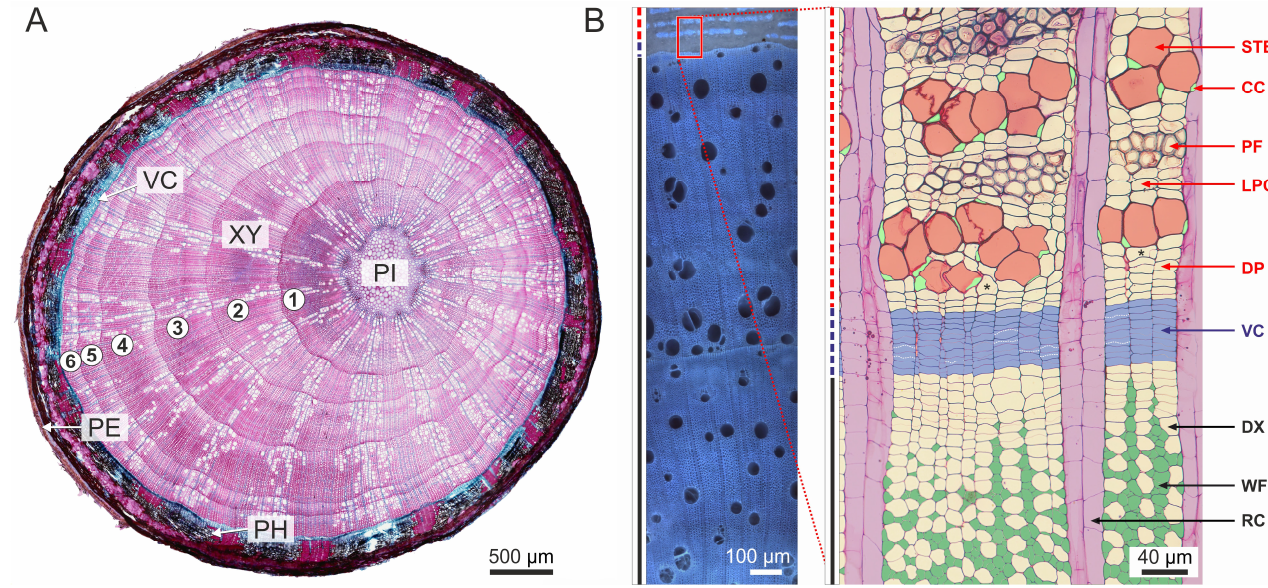
Figure 1. Transverse sections of stems of broadleaved tree species. ( A ) Six-year-old branch of Carpinus betulus L. Successive xylem increments are numbered 1–6. The sample was cut with core- microtome and examined using bright-field microscopy. Double staining was used (unlignified cells are stained blue by astra blue; lignified elements are stained red by safranin O). XY—xylem;